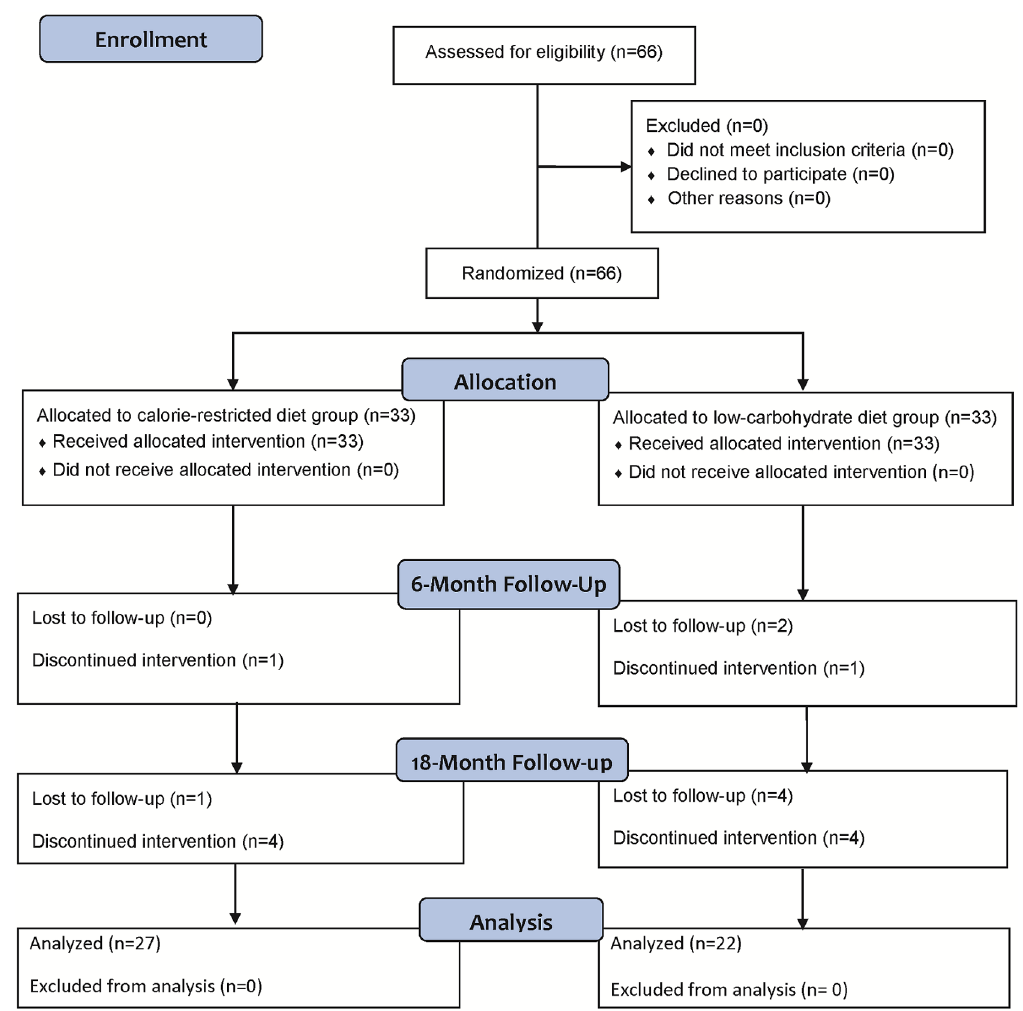
Fig 1. Study flow chart. The baselinedata of the study subjectsare shown in Tables 1 and 2. Except for age and fat intake, other data were well-matched. transferring to the different hospitals) and 4 were lost to follow-up (with admission to the hos- pital due to the different disease and diabetes), resulting in 22 patients completing the 1-year follow up (Fig 1). We were therefore able to obtain the body weight and blood data of a total of 49 patients for 18 months, including the 6-month RCT period, in addition to 3-day weighed/ measured food records and a completed Diabetes Treatment Satisfaction Questionnaire (DTSQ) from 38 patients (CRD:19, LCD:19) at the end of the follow-up period. Five patients in the CRD group and 4 in the LCD group increased the dosage of their oral medications (CRD: metformin, 4; sulfonylurea, 1; LCD: metformin, 3; thiazolidine, 1). Five patients in the CRD group and 6 in the LCD group decreased their oral medication dosages (CRD: metformin, 2; Dipeptidyl peptidase-4 inhibitors [DPP4-I], 1; sulfonylurea, 1; thiazoli- dine, 1; LCD: metformin, 2; alpha-glucosidase inhibitor [ α -GI]: 1; sulfonylurea, 3). Eleven patients in both the CRD and LCD groups started new oral medications (CRD: metformin, 2; DPP4-I, 2; Sodium-glucose co-transporter-2 inhibitors [SGLT2-I], 6; thiazolidine, 1; LCD: metformin, 1; DPP4-I, 2; glinide, 3; SGLT2-I, 4; sulfonylurea, 1). Six patients in the CRD